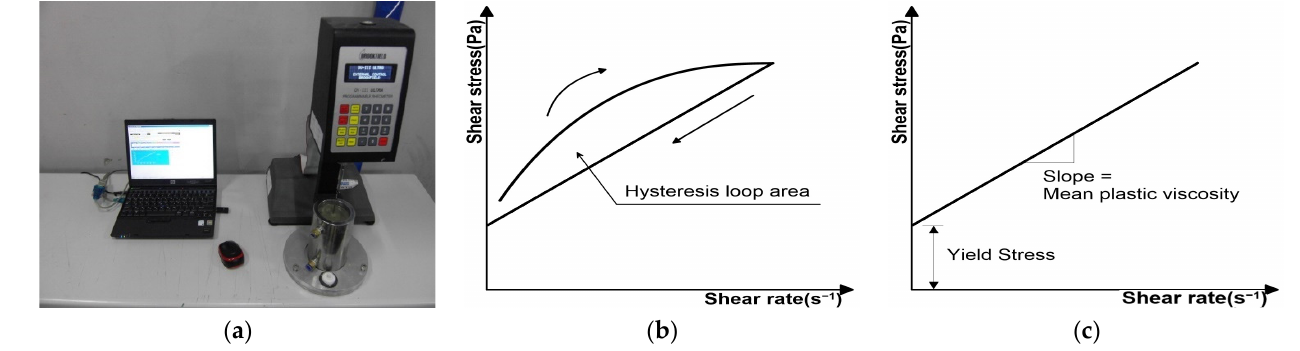
Figure 6. Rheological analysis method: ( a ) mortar viscometer; ( b ) hysteresis curve; ( c ) bingham